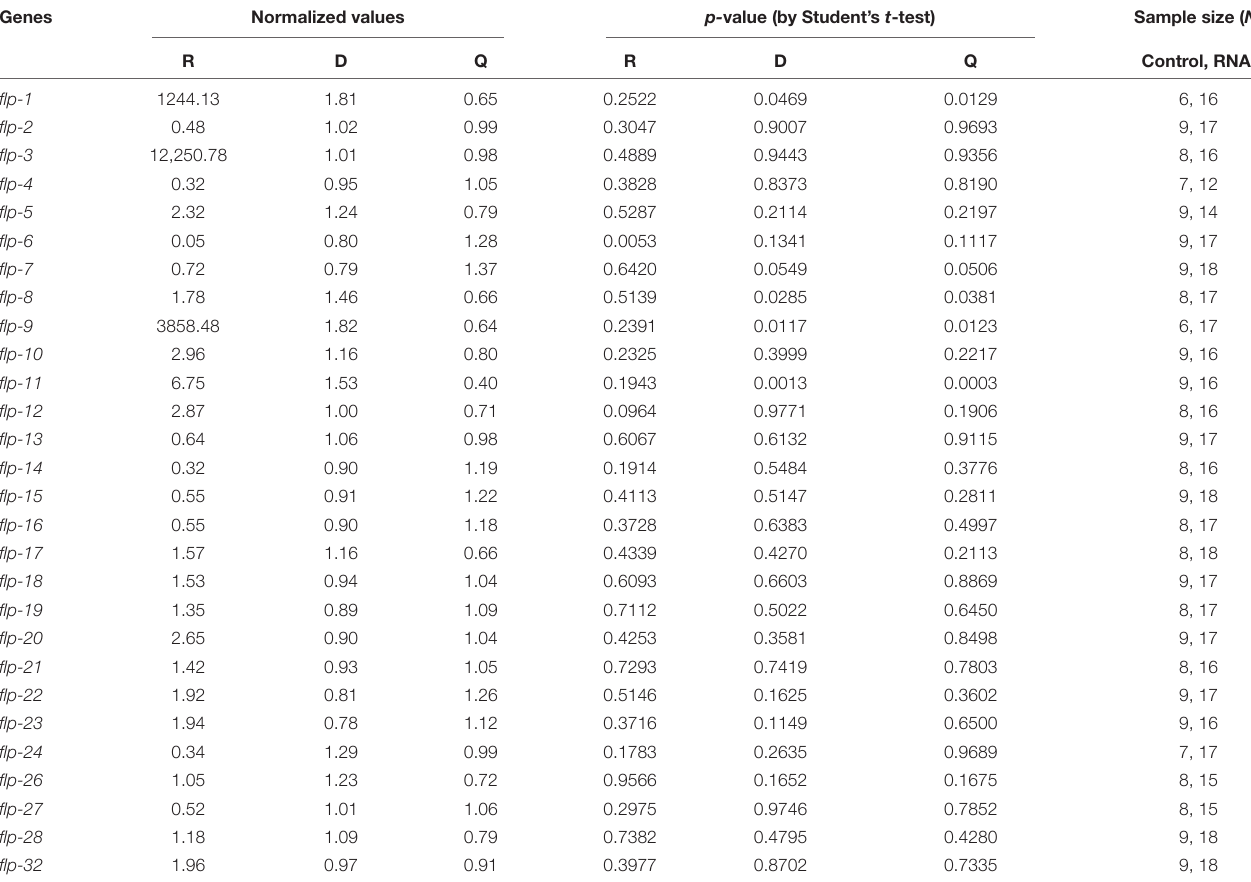
TABLE 1 | Normalized values of each state of roaming, dwelling and quiescence, the sample size, and statistical significance of 28 flp genes. Genes Normalized values p- value (by Student’s t -test) Sample size ( N